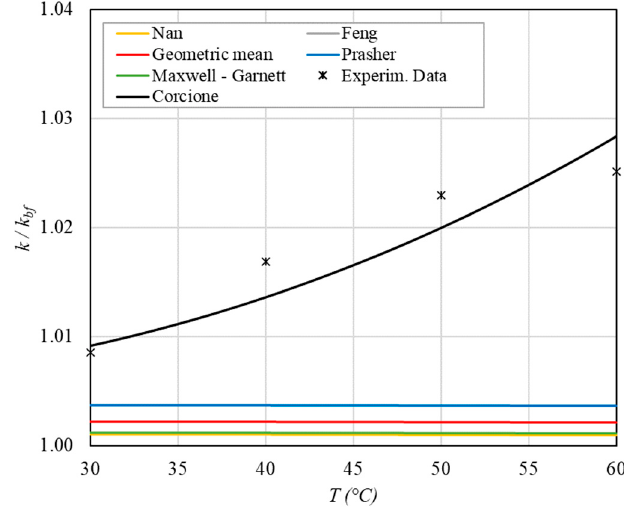
Figure 5. Increase in thermal conductivity as a function of temperature for φ = 0.04% .